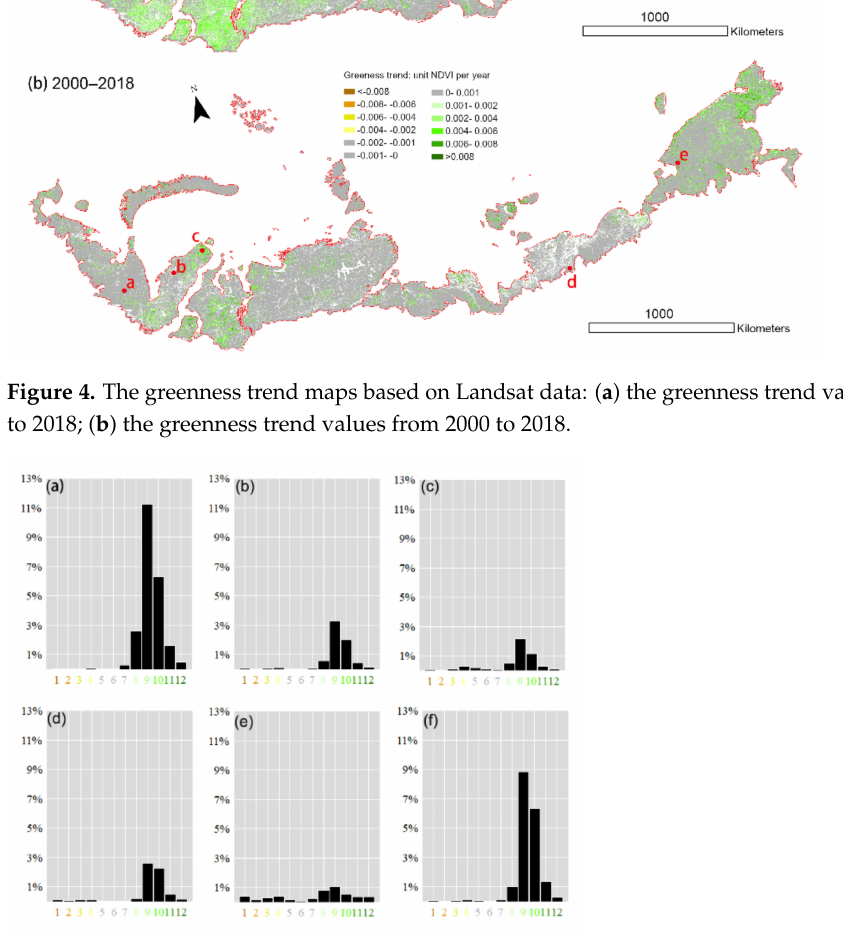
Figure 5. NDVI trend in the period of 2000–2018 for the geographical regions: ( a ) CT; ( b ) EET; ( c ) EST; Figure 4. Table 2. Area percent of the greenness trends in the selected geographical regions (EET and WET) during